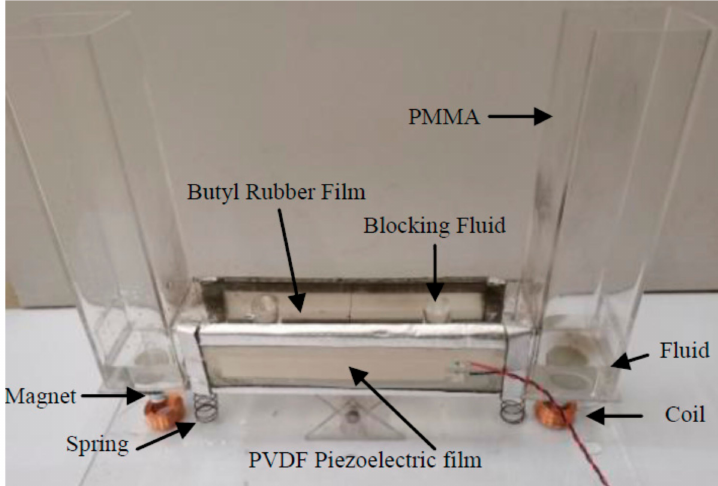
Figure 2. Photograph of the fabricated hybrid energy